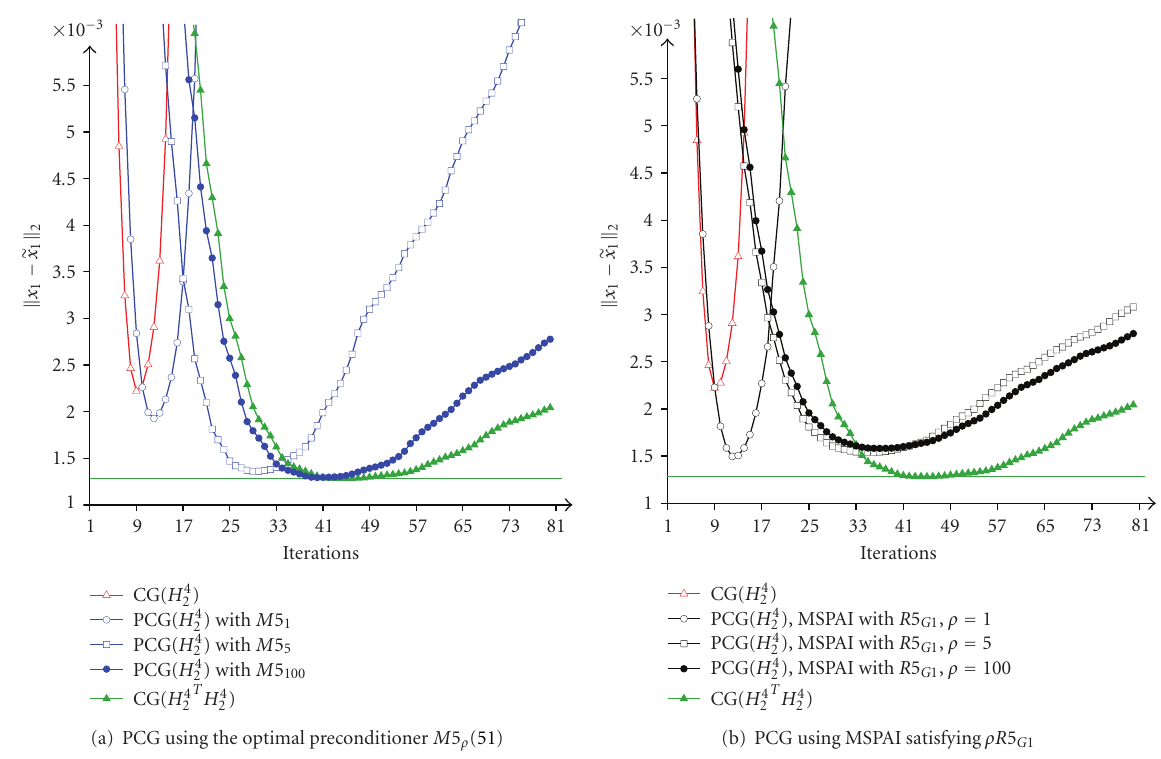
Figure 6: Reconstruction error against the iteration for the 2D problem with blur operator H 4 2 and original data x 1 of size n = 50 2 a ff ected by random noise of order 0.1%. CG is compared to CG for the normal equations and to M 5 ρ (a) and MSPAI satisfying ρR 5 G 1 (b), respectively.